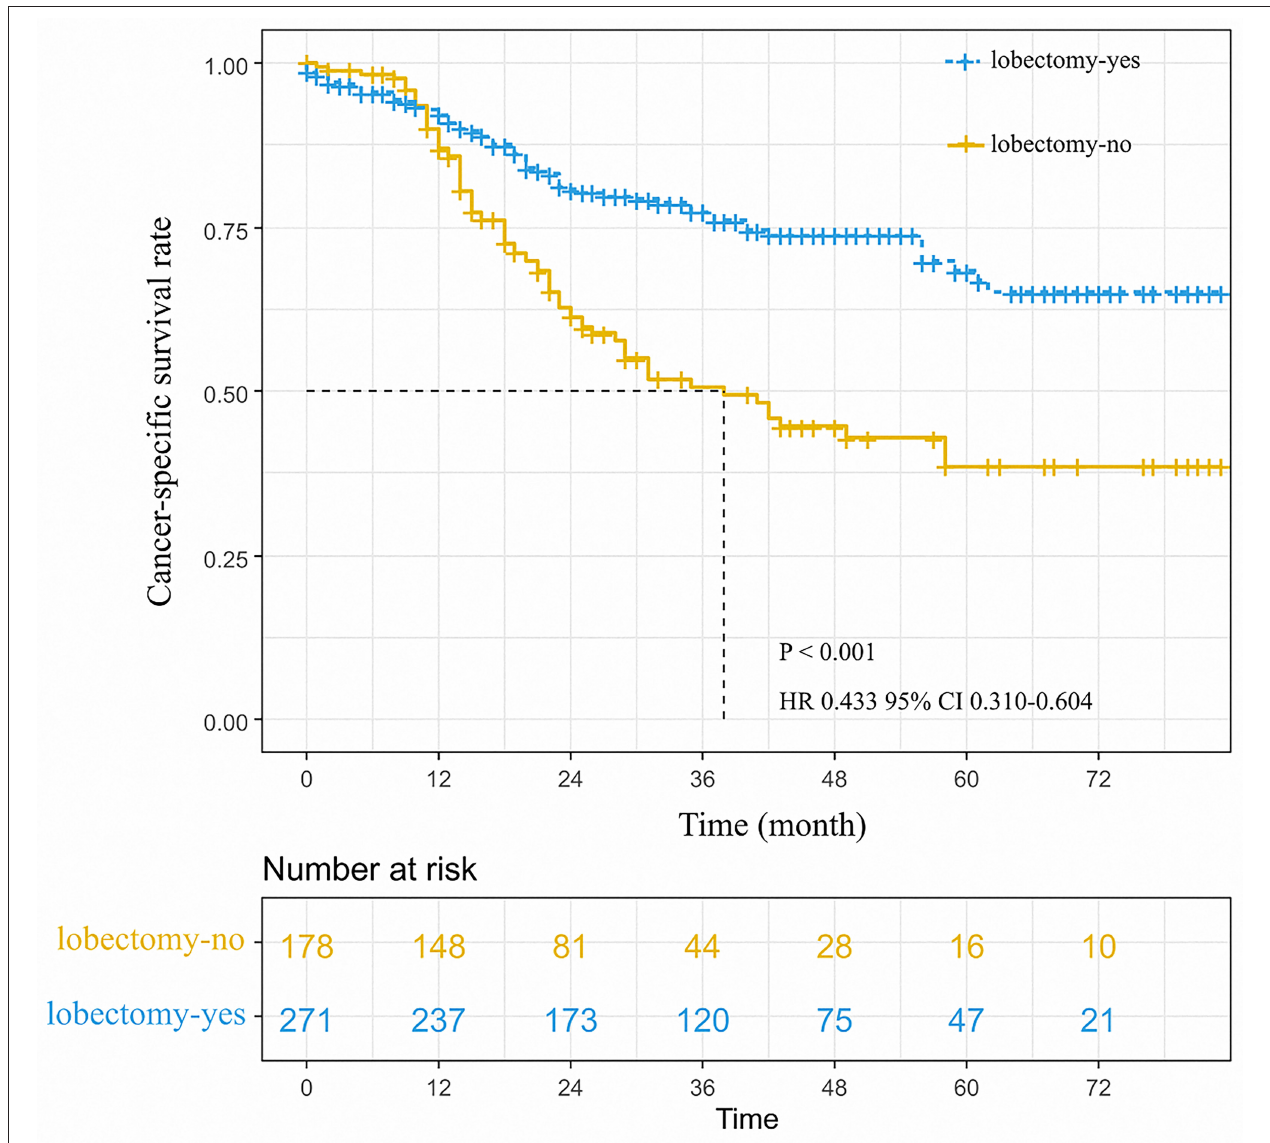
FIGURE 4 | Cancer-specific survival curve for small cell lung cancer patients according to the surgical